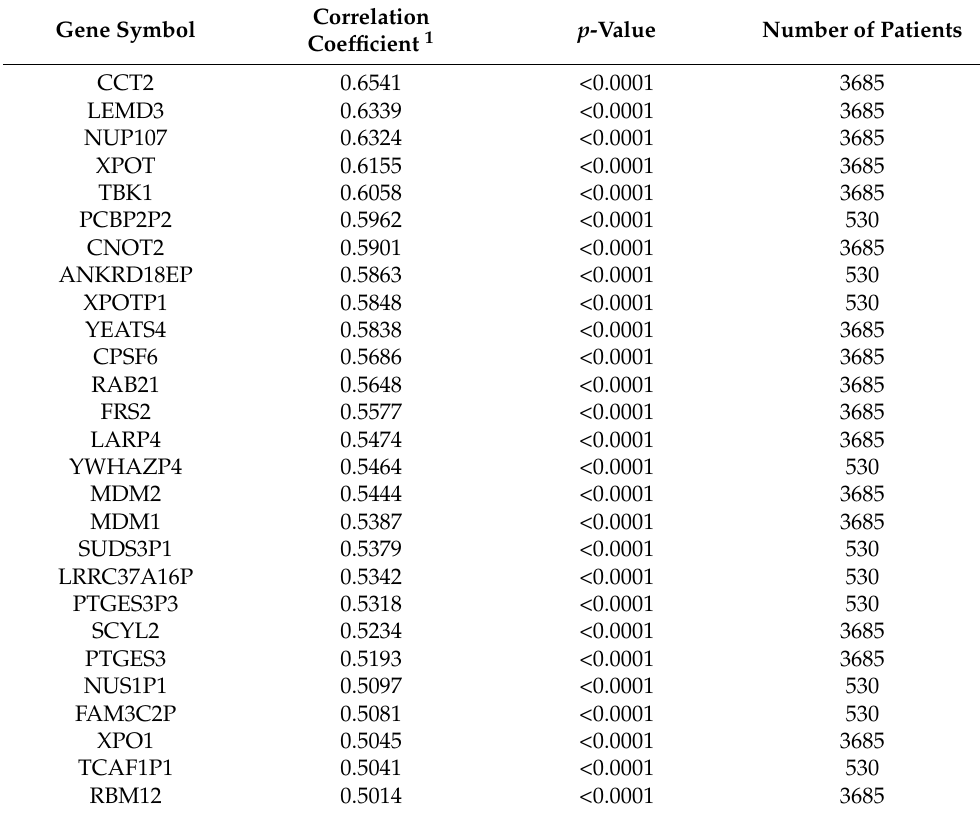
Table 1. Genes that correlate positively with CAND1 in ER α -positive breast cancer patients. Gene Symbol